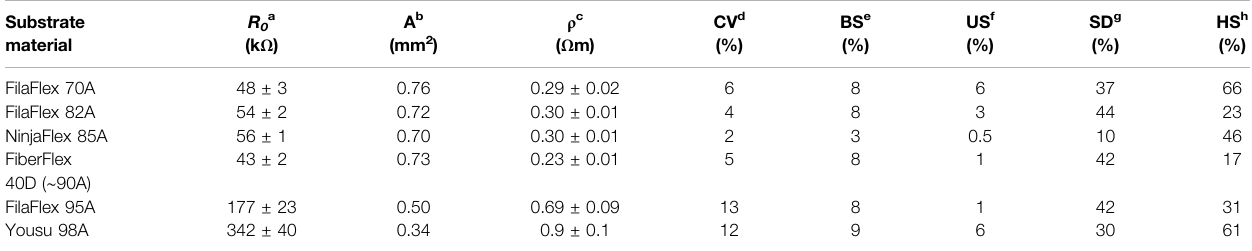
TABLE 2 | Values of the initial resistance R 0 , the coef fi cient of variation, and the strain values where buckling and uncertainty can be overserved as well as the signal drift at 30% strain and the hysteresis at 15% strain for the different TPU-based strips during the dynamic tensile test at strain 0 – 30%. The buckling is derived from Supplementary Figure S4 . The cross-section of the samples was calculated based on images using the optical microscope in Supplementary Figure S3 . The uncertainty, drift, and hysteresis are derived from Figure 4 . Substrate material